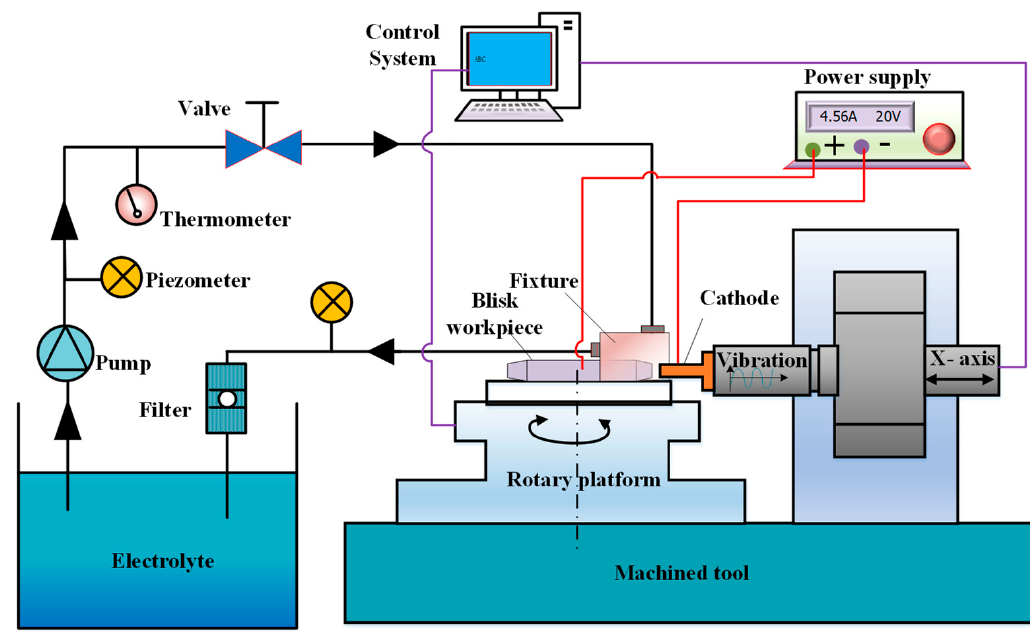
Figure 11. The set-up for electrochemical machining.